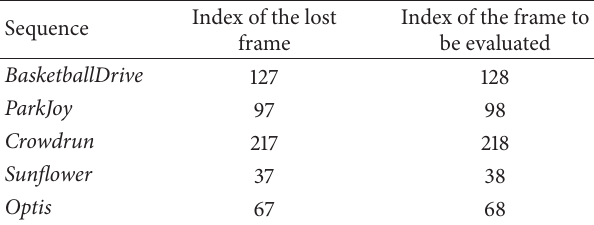
Table 1: Lost frame index of each